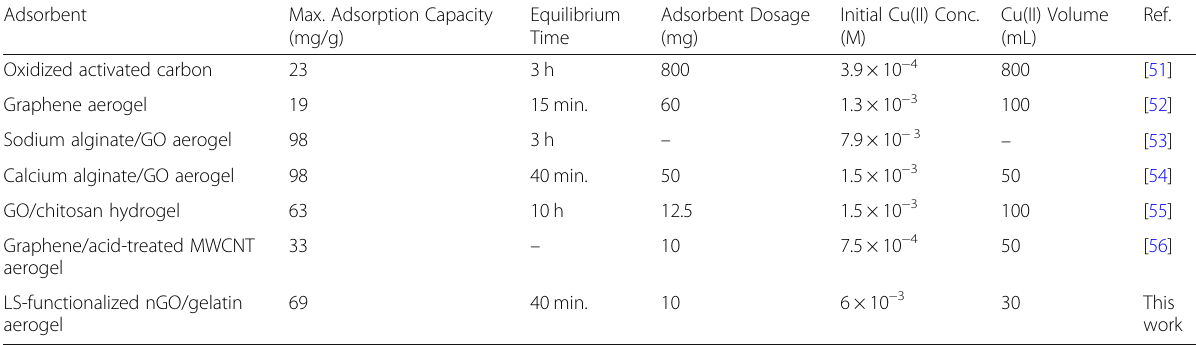
Table 3 Comparison of Cu(II) adsorption capacities of various carbonaceous adsorbents